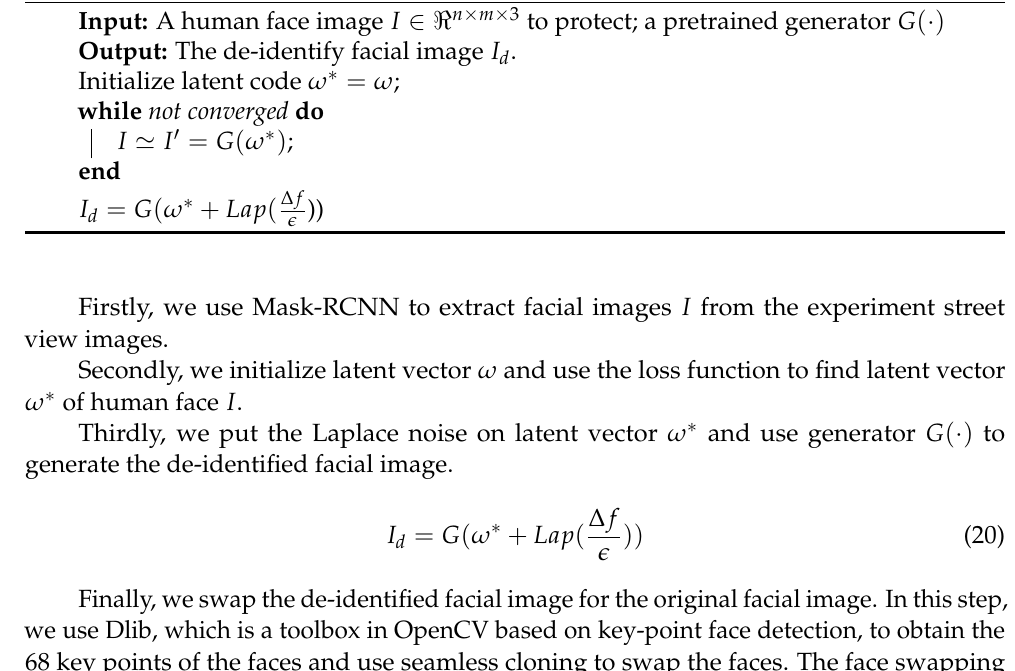
Algorithm 3: Facial image de-identification.